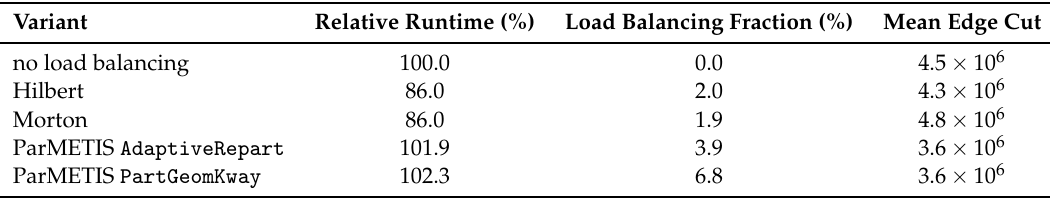
Table 3. Comparison of total runtime of the hopper simulation for the four load distribution variants relative to the case without load balancing. Additionally, the runtime of the load balancing step relative to the total runtime and the simulation-averaged edge cut is given.